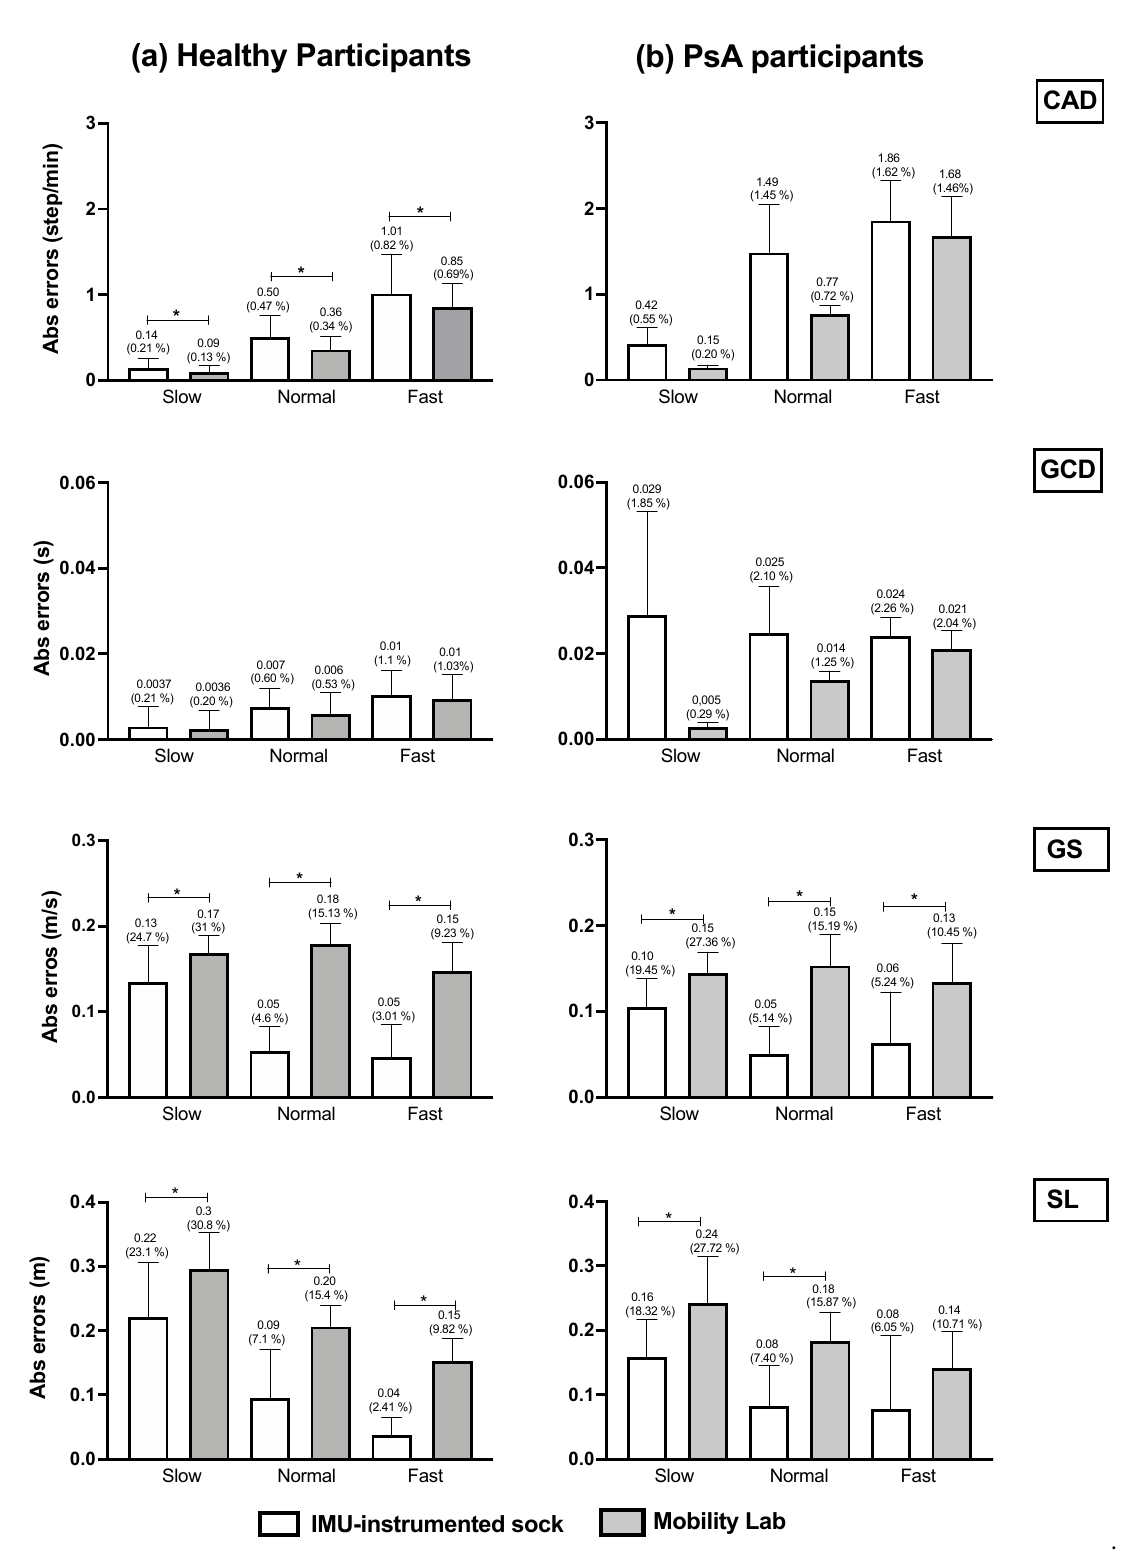
cycle duration (GCD), gait speed (GS), stride length (SL), and Motion capture system (Mocap). The solid lines indicate the mean test-retest differences (bias) and the dashed lines indicate the upper and lower 95% limits of agreement (1.96 SD of the bias). Dashed green, red, and blue squares represent the observations for slow, normal, and fast speeds, respectively.